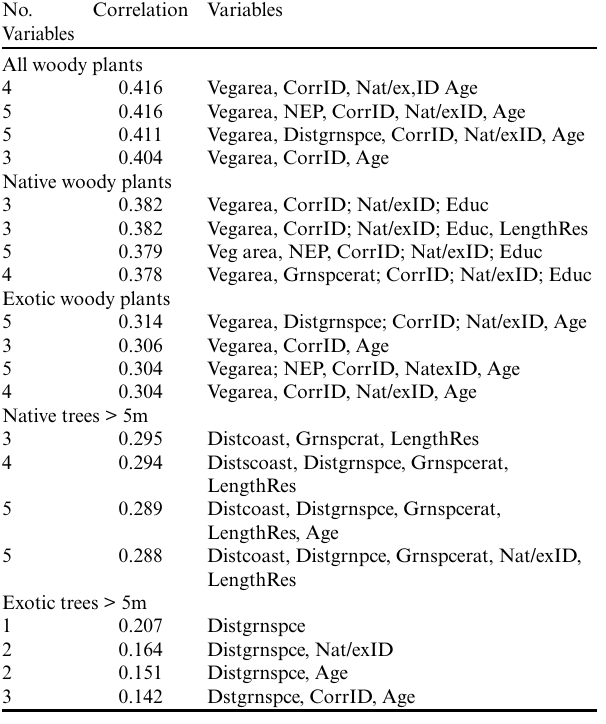
Table 3 . Top four best-matching patterns within the species assemblage identified by Best Biota Environmental (BIO-ENV) of woody plants in 55 gardens. Vegarea = vegetated area; Distcoast = distance to the coast; Distgrnspce = distance to nears green space (> 4ha); Grnspcrate = green space rating within neighbourhood; NEP = New Ecological Paradigm score; CorrID = score for correctly identifying common species; Nat/exID = score for correctly discriminating between common native and exotic species; Age = age of householder; LengthRes = length of residence (yrs).